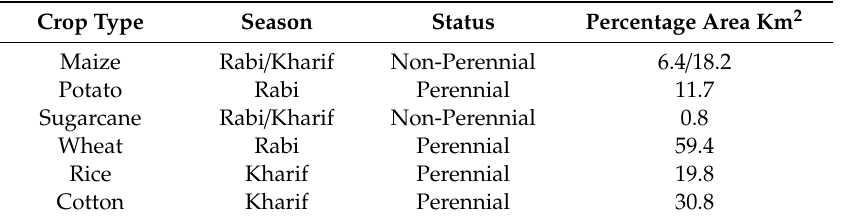
Table 2. Crop types statistics in study area.